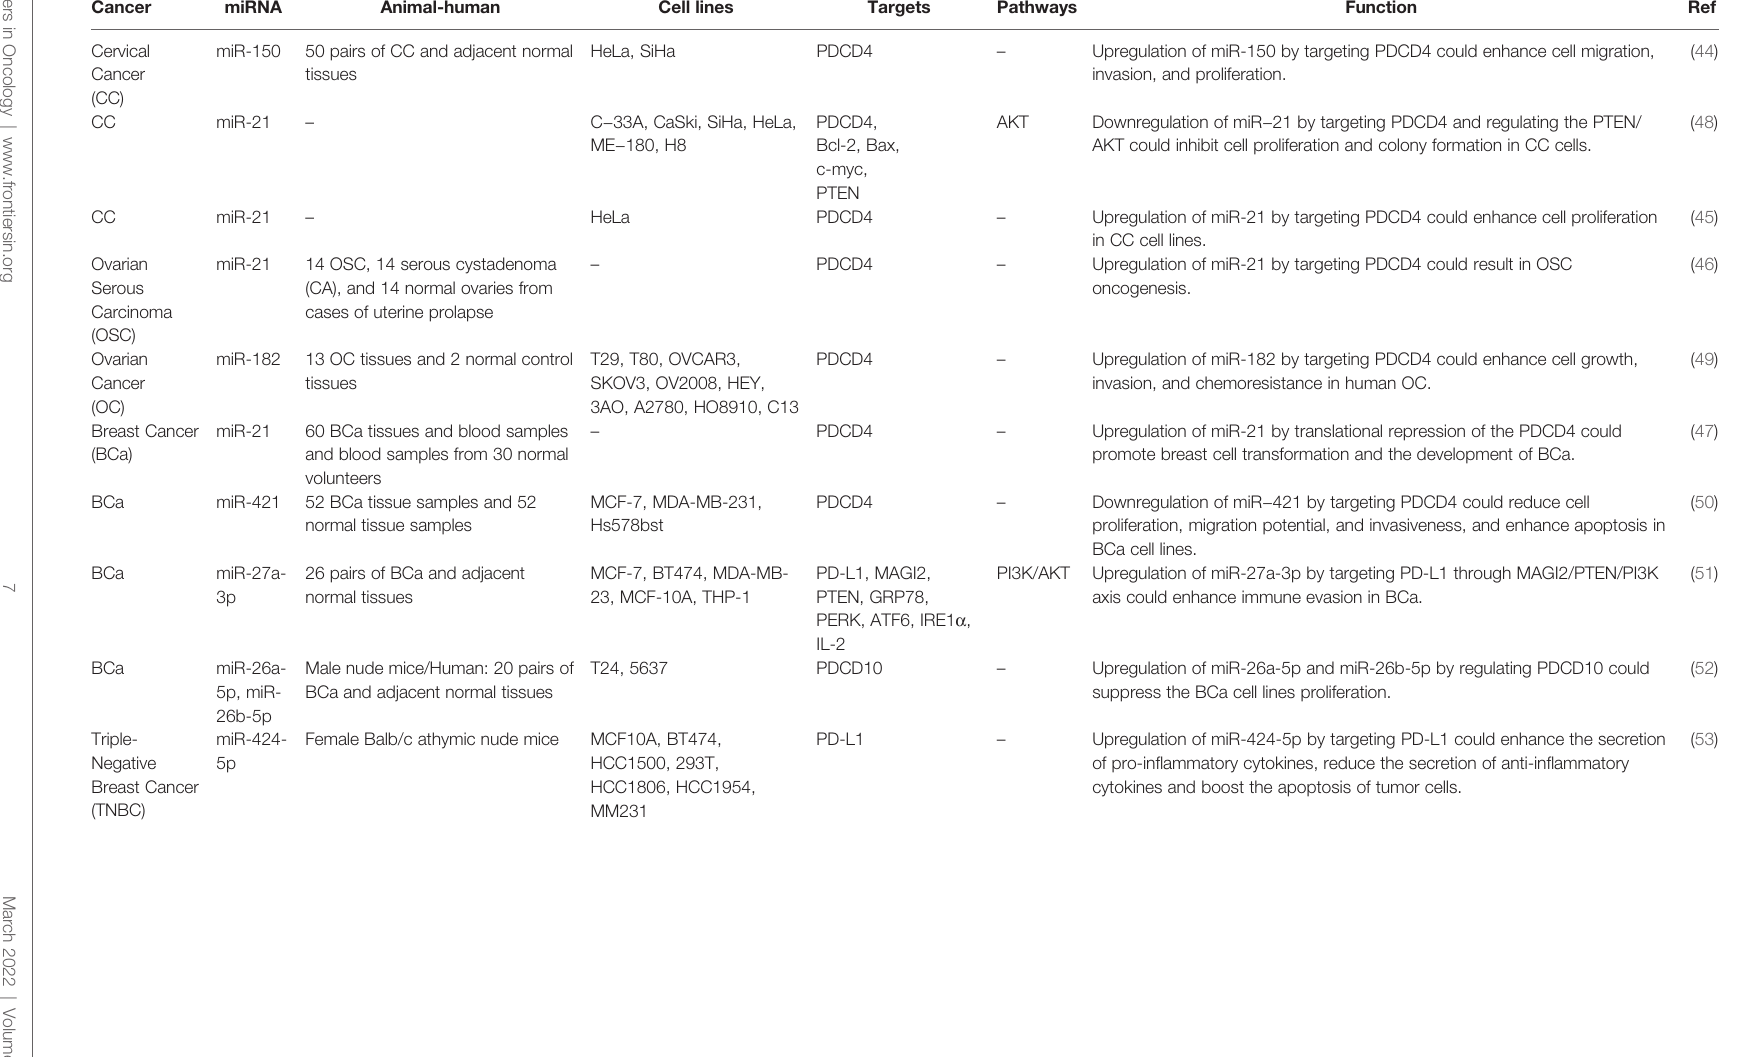
TABLE 4 | Interaction between miRNAs and PDCD in female cancers. Cancer miRNA Cervical